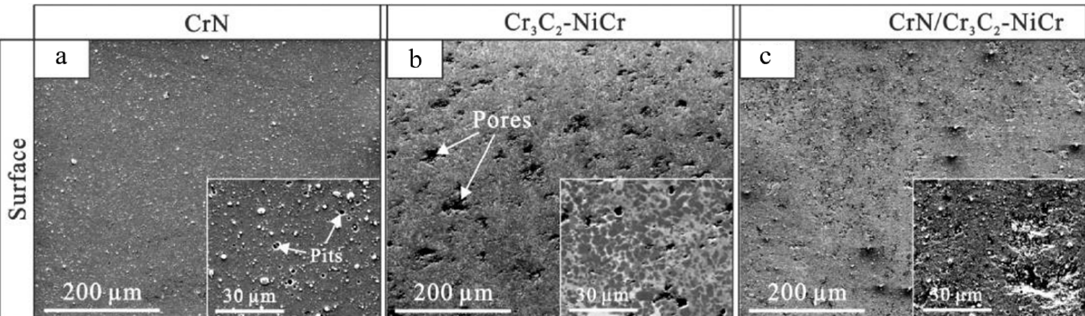
Figure 5. Surface SEM images of ( a ) PVD CrN coating, ( b ) HVOF Cr 3 C 2 -NiCr coating, and ( c ) HVOF- PVD CrN/Cr 3 C 2 -NiCr duplex coating. Reprinted with permission from Ref. [55]. Copyright Elsevier,